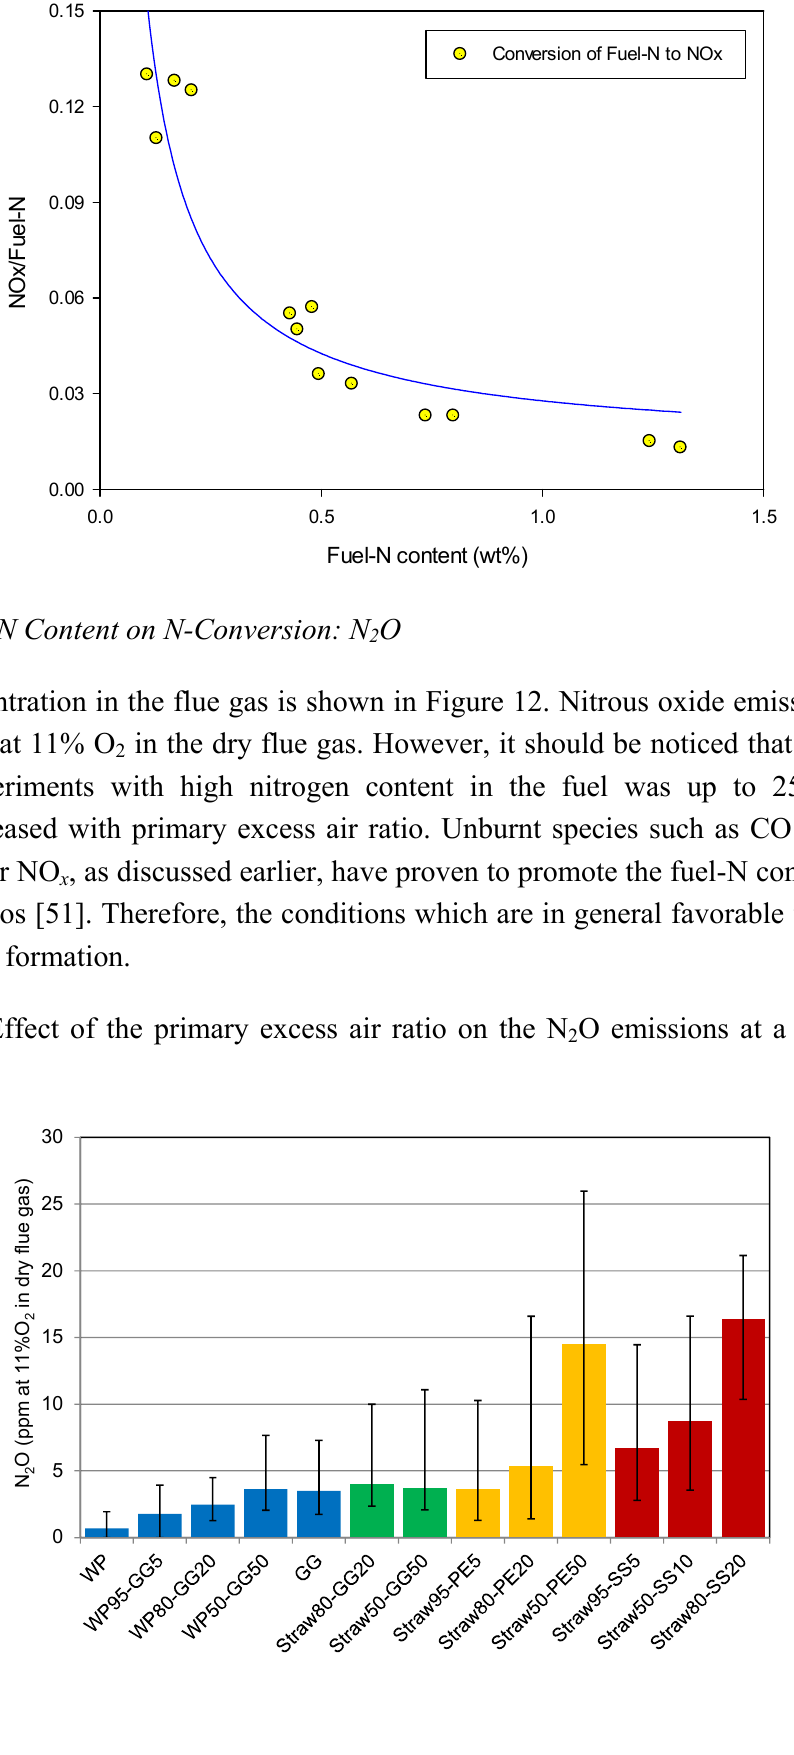
Figure 11. Influence of fuel-N content on the conversion to NO